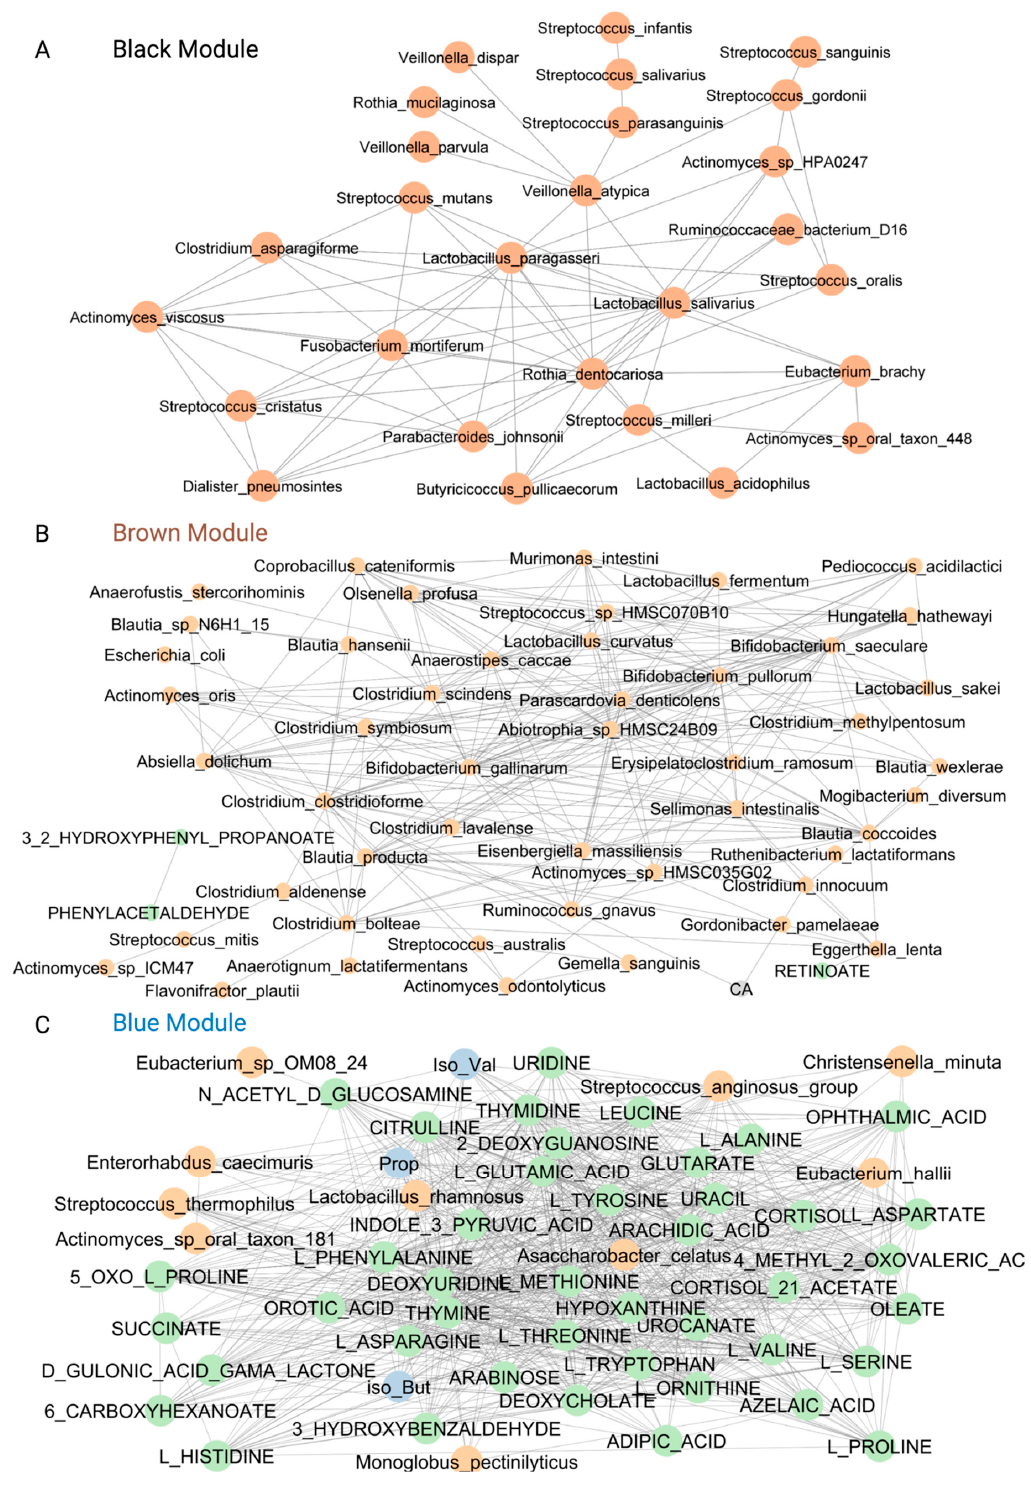
Figure 5. Modules enriched for High-Risk CAG taxa. ( A ) The black module shows taxa (shown in orange) associated with the three clusters predicted to have pathobiont traits. Abbreviations: sp, species. ( B ) The brown module shows species with pathobiont characteristics that are known to be increased in disease. Abbreviations: CA, cholic acid; AC, acid. ( C ) The blue module shows microbial taxa and metabolites (SCFA shown in blue, all other metabolites shown in green) often elevated in disease. Abbreviations: Iso_val, isovalerate; iso_But, isobutyrate; pro, propionate; 5-OXO-L proline, 5-oxoproline (pyroglutamic